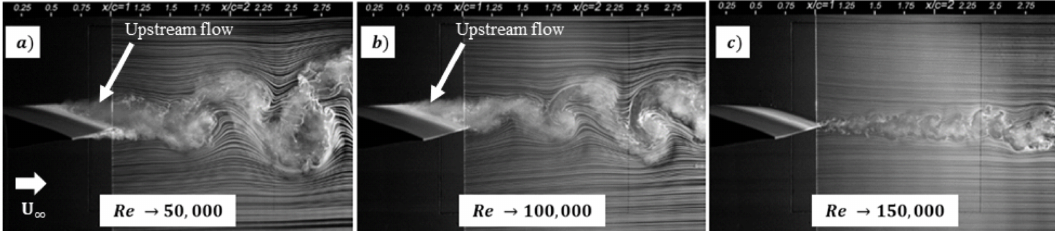
Figure 1. Shedding of vortices from the trailing edge of NACA 0025 airfoil at different Reynolds numbers ( a ) 50,000 ( b ) 100,000 ( c ) 150,000 (adapted from Yarusevych